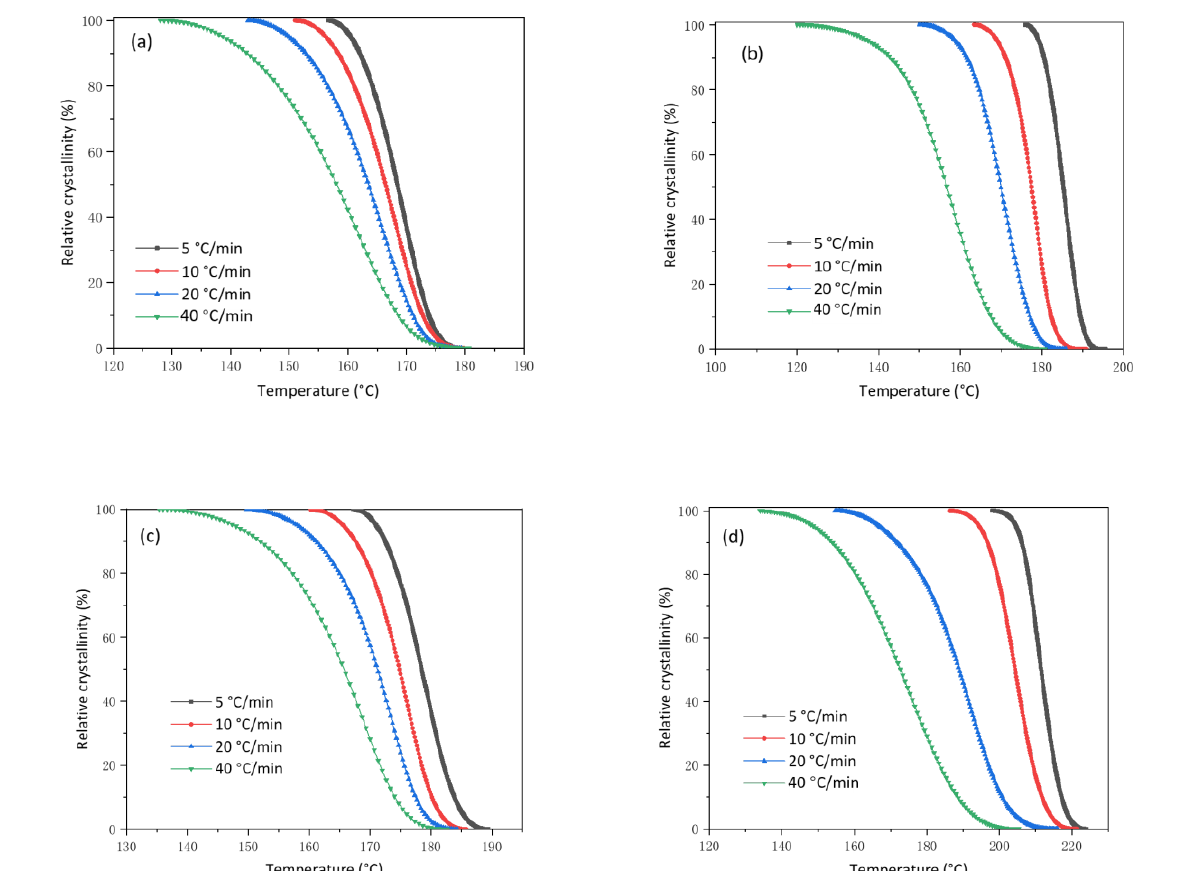
Figure 9. Relative crystallinity of TPAE-1000 ( a ), TPAE-1500 ( b ), TPAE-2000 ( c ) and PA10T/10I ( d ) as a function of temperature at different cooling rates.